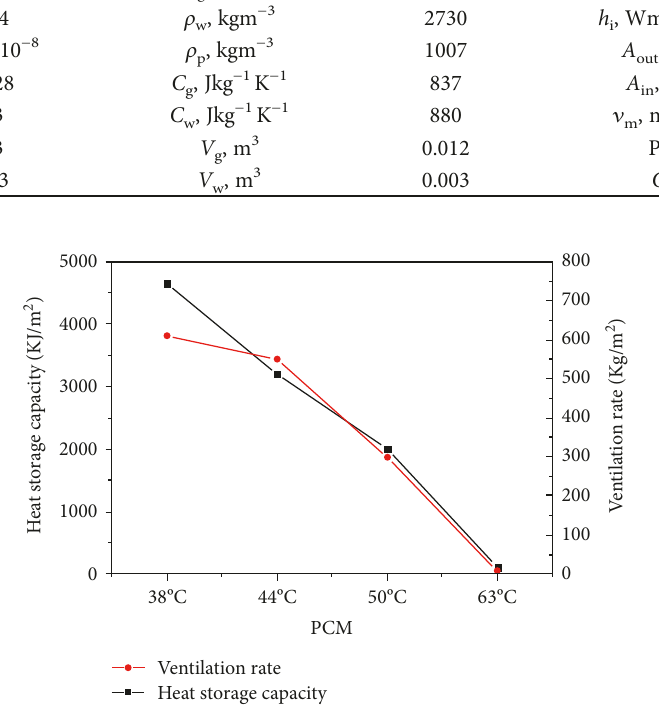
Figure 3: Thermal storage capacity and air fl ow rate for four di ff erent